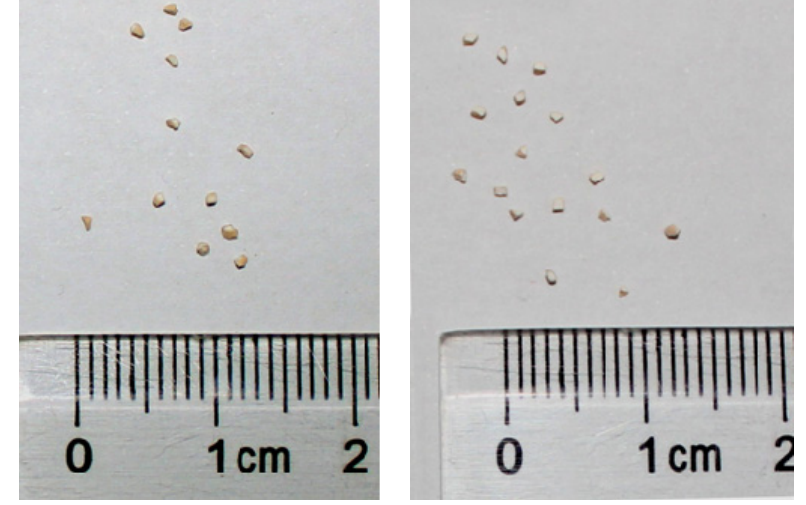
O ; Right: PdO/La 2 3